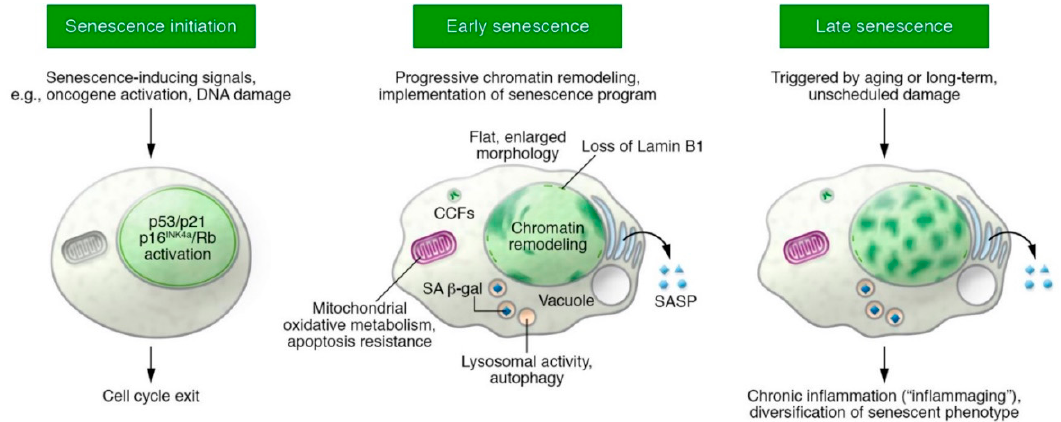
Figure 4. Phenotypic Characteristics of Senescent Cells: Diagram depicting some of the phenotypic alterations associated with senescence initiation, early senescence, and late phases of senescence, which suggest that senescence is a dynamic rather terminal phenomenon. Figure reproduced with permission from Herranz N. and Gil J. [243].